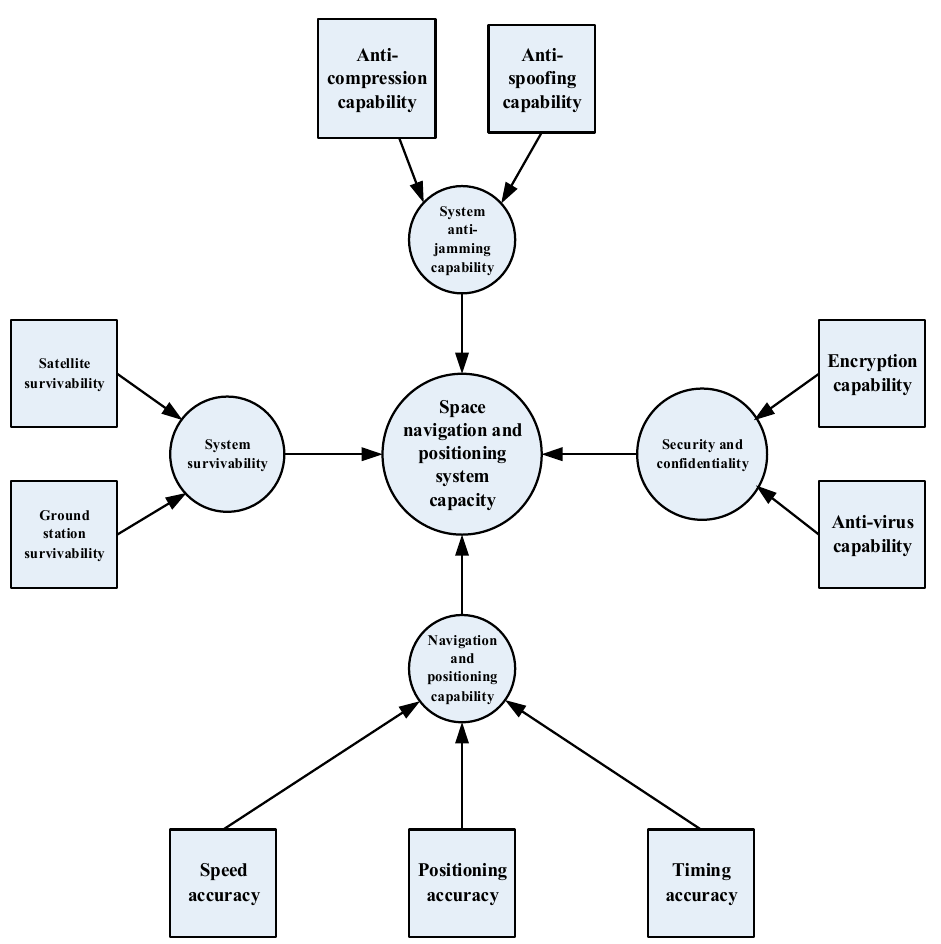
Figure 1. Evidential network structure for the capabilities of the space-navigation-and-positioning system of systems. system of